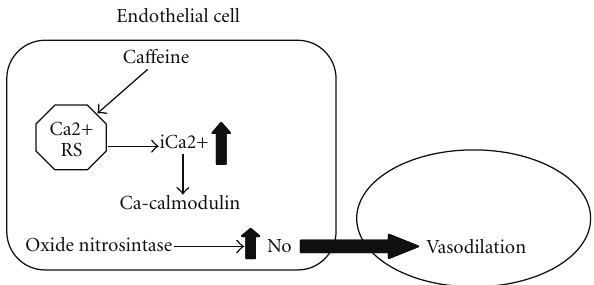
Figure 4: Indirect e ff ects of ca ff eine on VSMC. Ca ff eine acts on the endothelial cell increasing cytoplasmic Ca 2+ which will form the calcium-calmodulin complex which activates the nitric oxide synthase enzyme to produce nitric oxide. This di ff uses to the